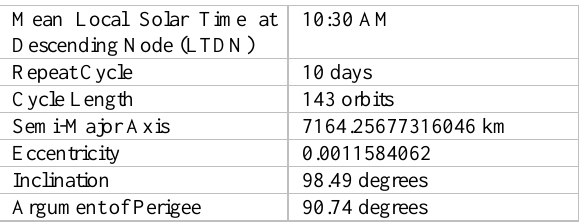
Table 1 : Nominal orbit parameters of S2A and S2B.